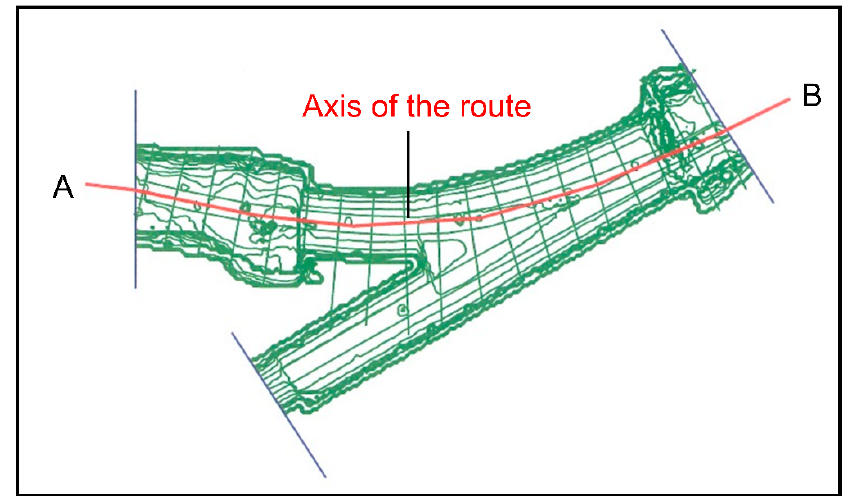
Figure 11. Determined axis of the route and direction of transport: A => B.